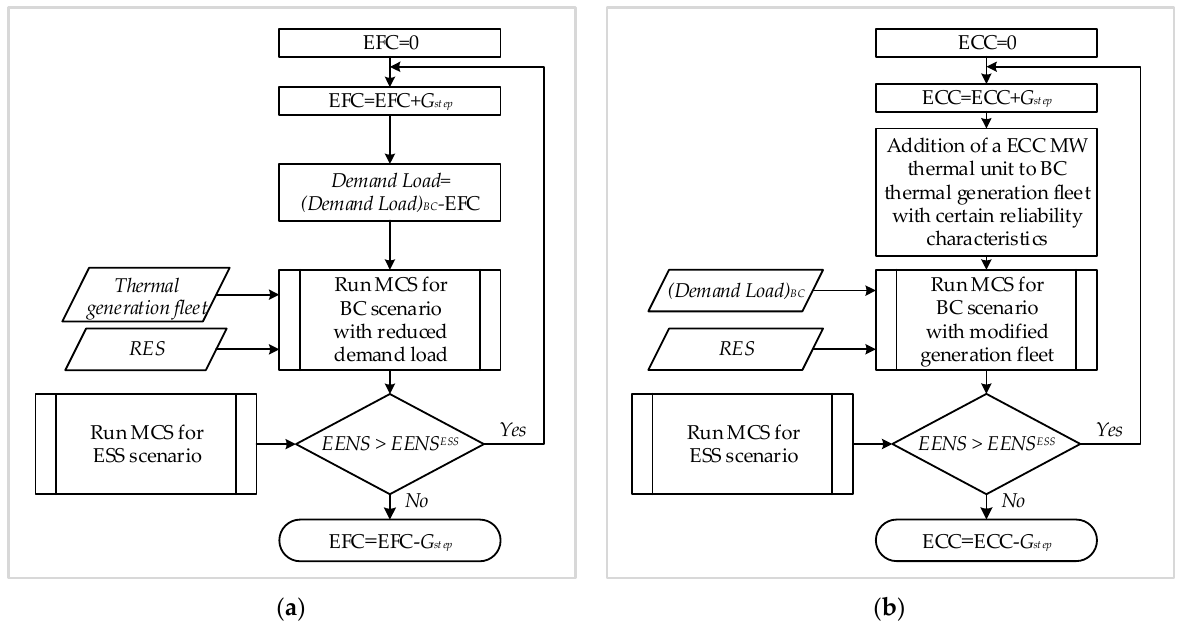
Figure 3. Methodology for calculating capacity value metrics: ( a ) EFC; ( b ) ECC.